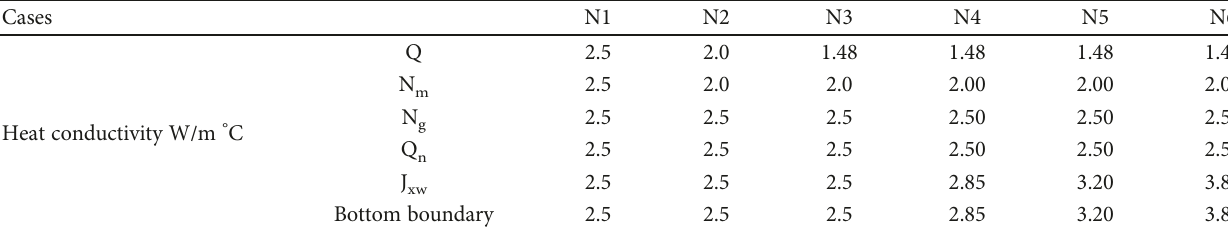
Table 3: Heat conductivity setting of each case (N1 – N6) (Q: Quaternary caprock; N Neogene; Q : Qingbaikou system; J n